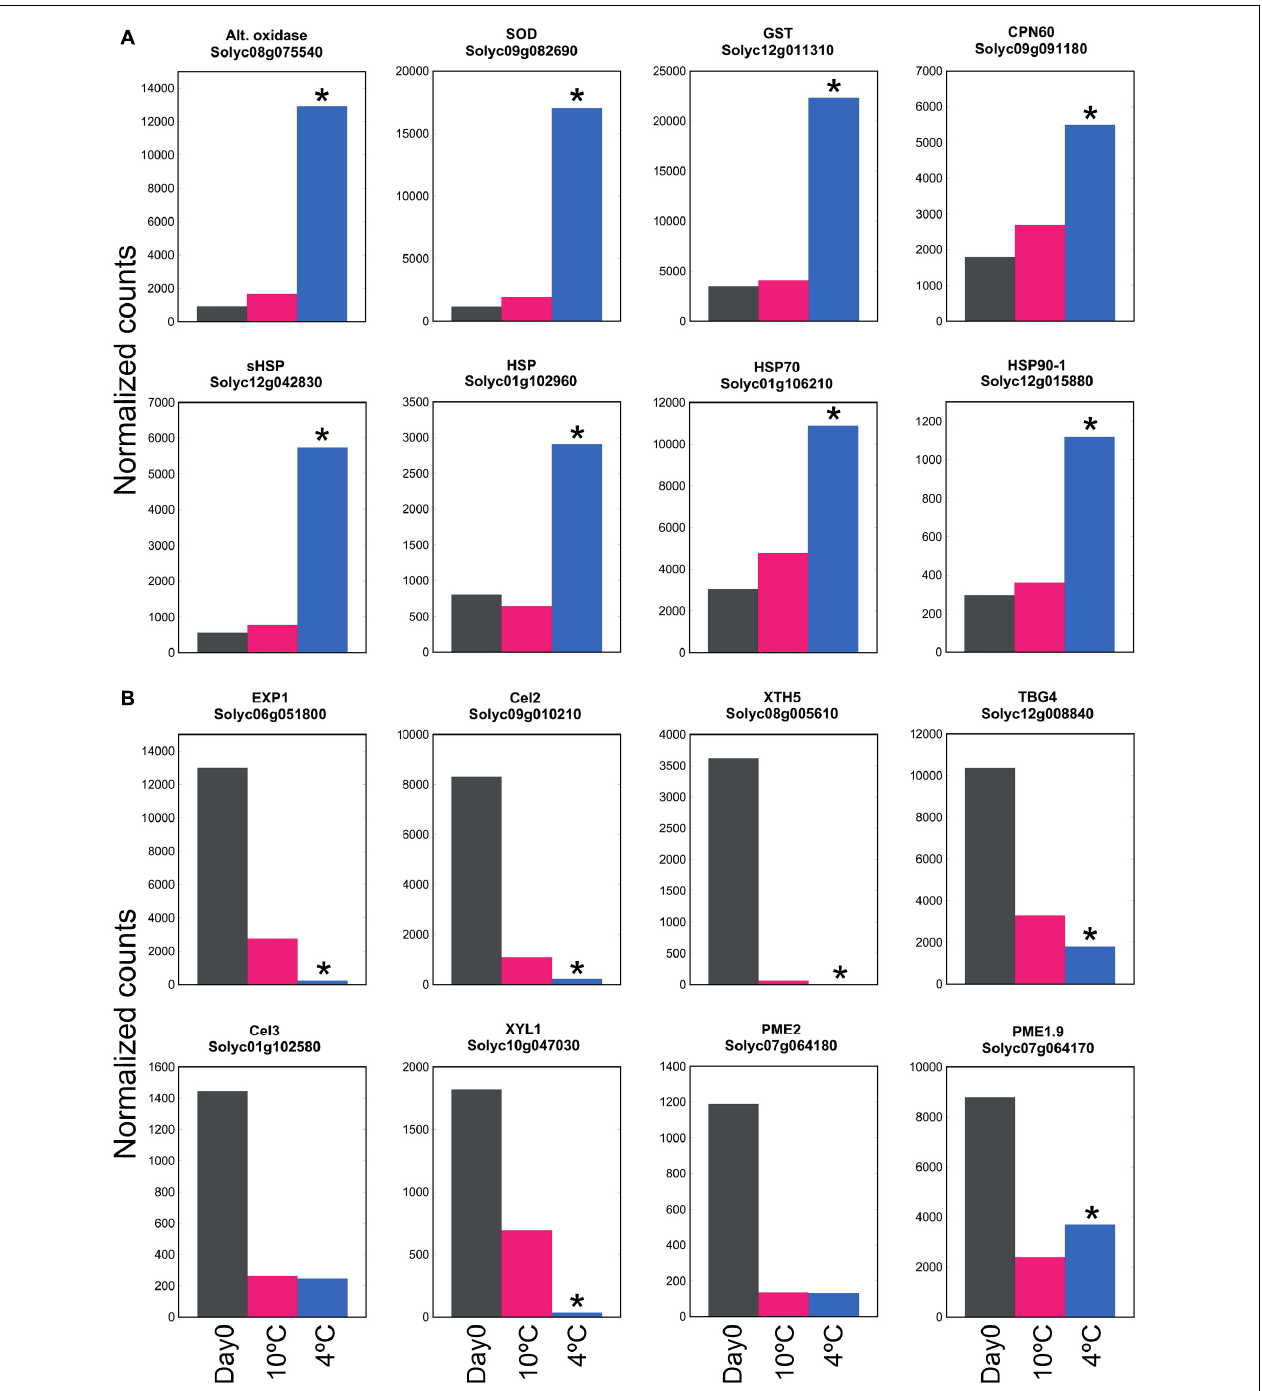
FIGURE 6 | Effect of exposure to mild or severe chilling temperature on transcript abundance of genes related to stress and ripening. (A) Oxidative and temperature stress. Genes encoding antioxidant enzymes, chaperonins and HSPs. (B) Genes related to cell wall modification. Fruit were exposed to 10 or 4 ◦ C for 6 days, and transcript abundance determined using RNA-Seq. Asterisks denote that transcript abundance at 4 ◦ C was significantly different to that at 10 ◦ C at P < 0.05.